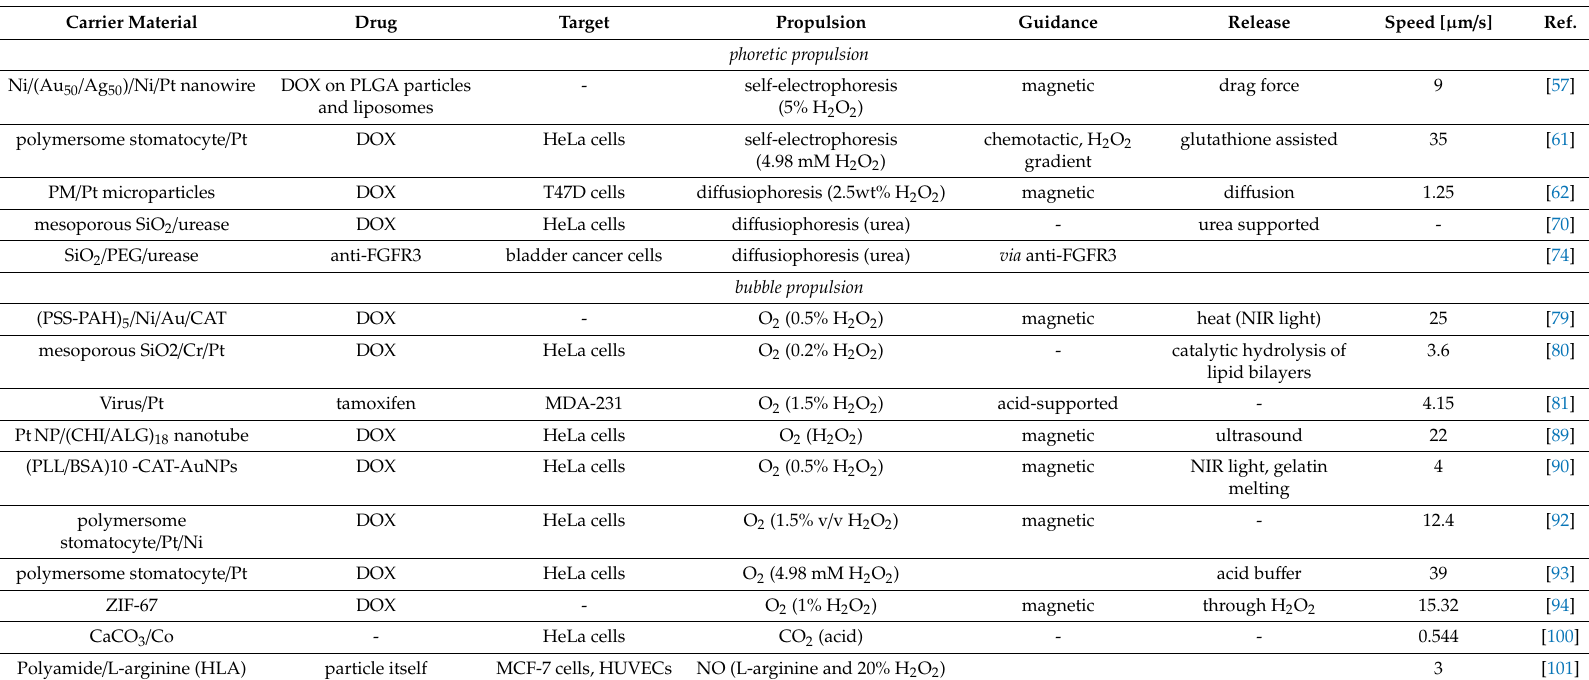
Table 1. List of phoretic and bubble-propelled nano-and micromotors for cancer